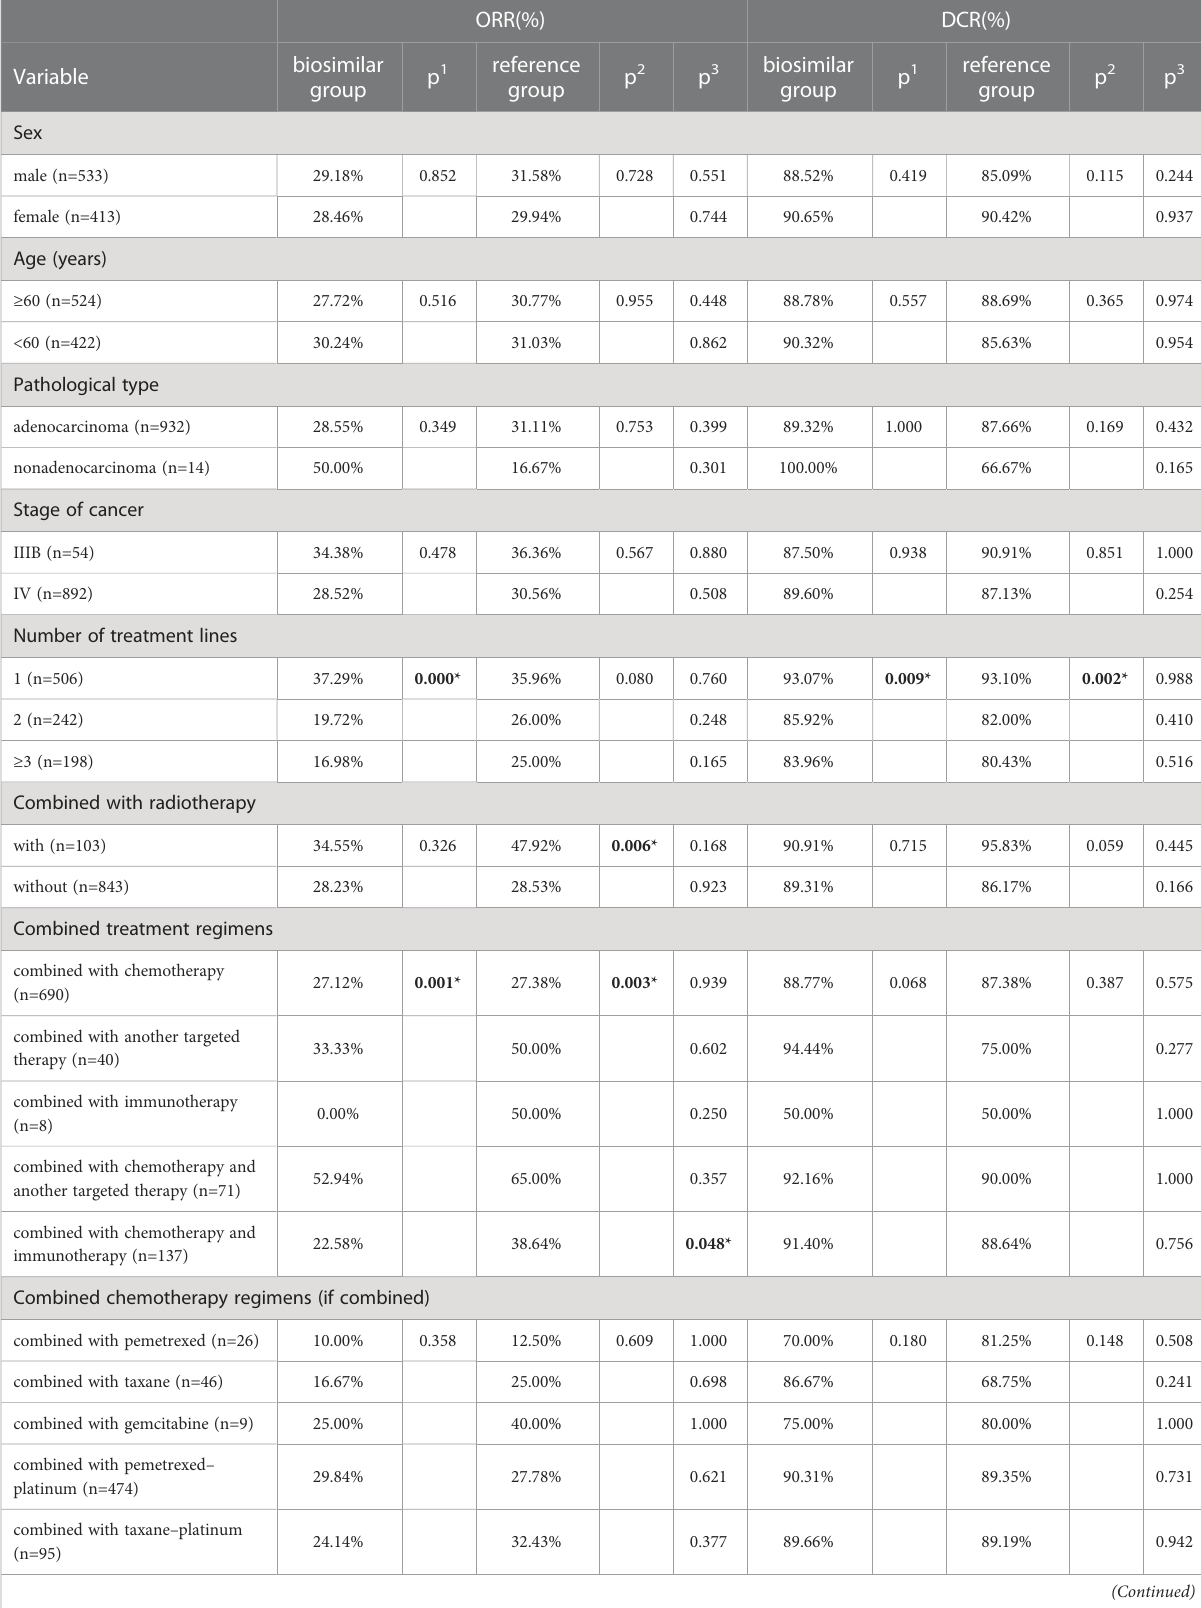
TABLE 3 Subgroup analysis of ORR and DCR between and within biosimilar and reference